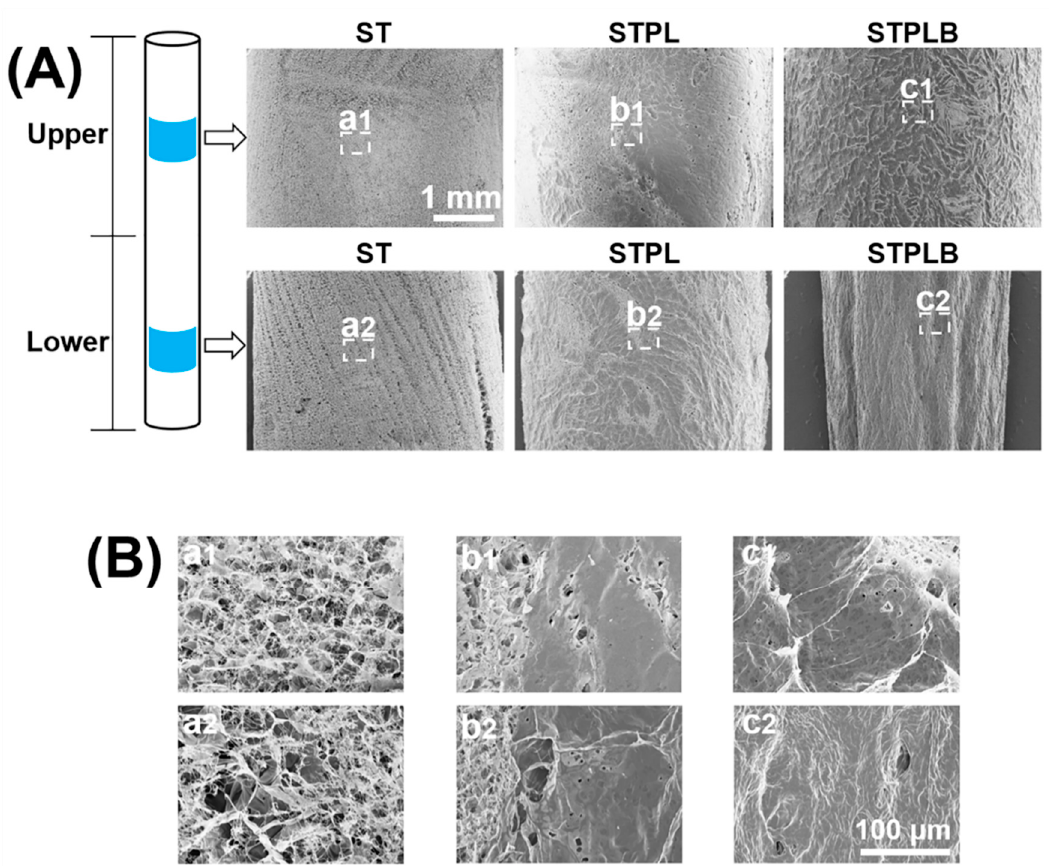
Figure 4. ( A ) Low and ( B ) high magnification of SEM images of the curved surfaces of gelatin